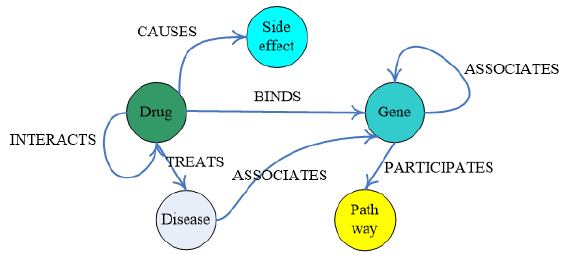
Figure 1. The schema of the local medical knowledge